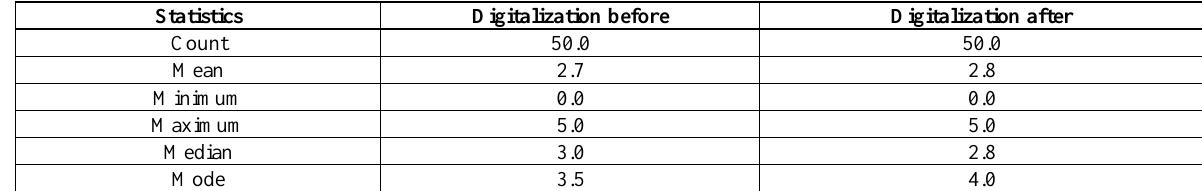
Table 2. Descriptive statistics of the digitalization